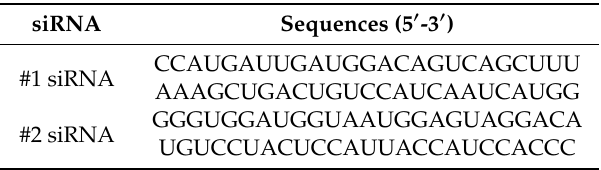
Table 2. siRNA sequences for Ythdf2